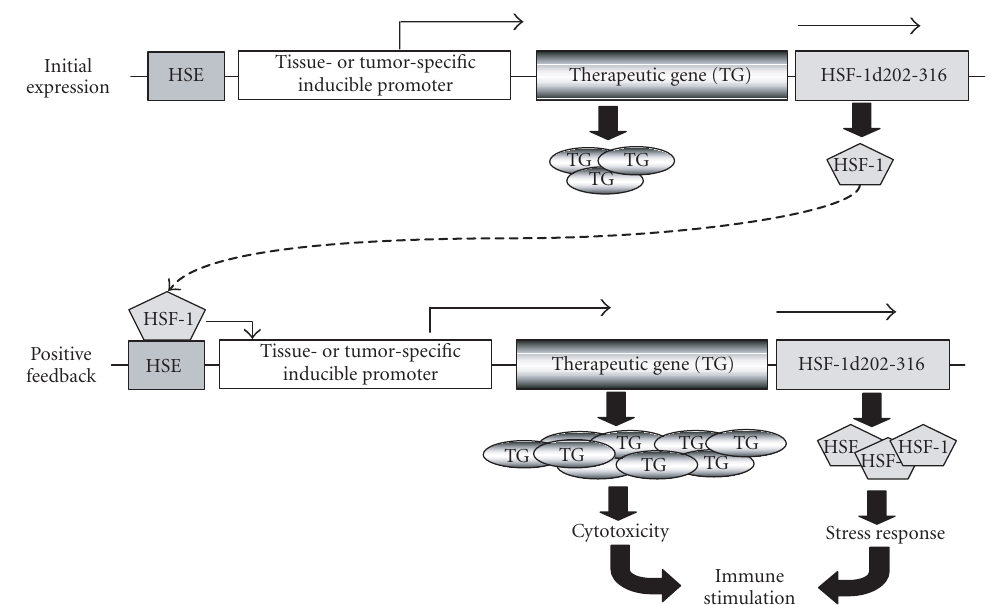
Figure 4. A transcriptional feedback loop for tissue-specific expression of highly cytotoxic genes which incorporate an immunostim- ulatory component. A weak tissue- or tumour-specific promoter will initially express the therapeutic transgene (TG) at low levels, however coexpression of the heat shock transcription factor (HSF-1) will activate the heat shock element (HSE) causing progressively increased TG and HSF-1 expression via a positive feedback loop. In addition, the expression of HSF-1 causes an immune response. Adapted from Emiliusen et al